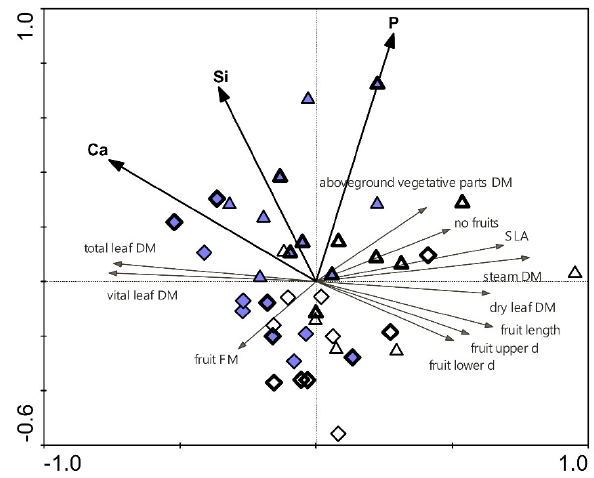
Figure 5. Redundancy analysis plot showing the strength of associations between some of the leaf element contents (Ca, Si, and P) and plant biomass and growth parameters. Symbol characteristics: diamonds, UV–; triangles, UV+; thick line, Si+; thin line, Si–; blue, W+; white, W–; DM, dry matter; FM, fresh mass. Stresses 2021 , 1 , FOR PEER REVIEW